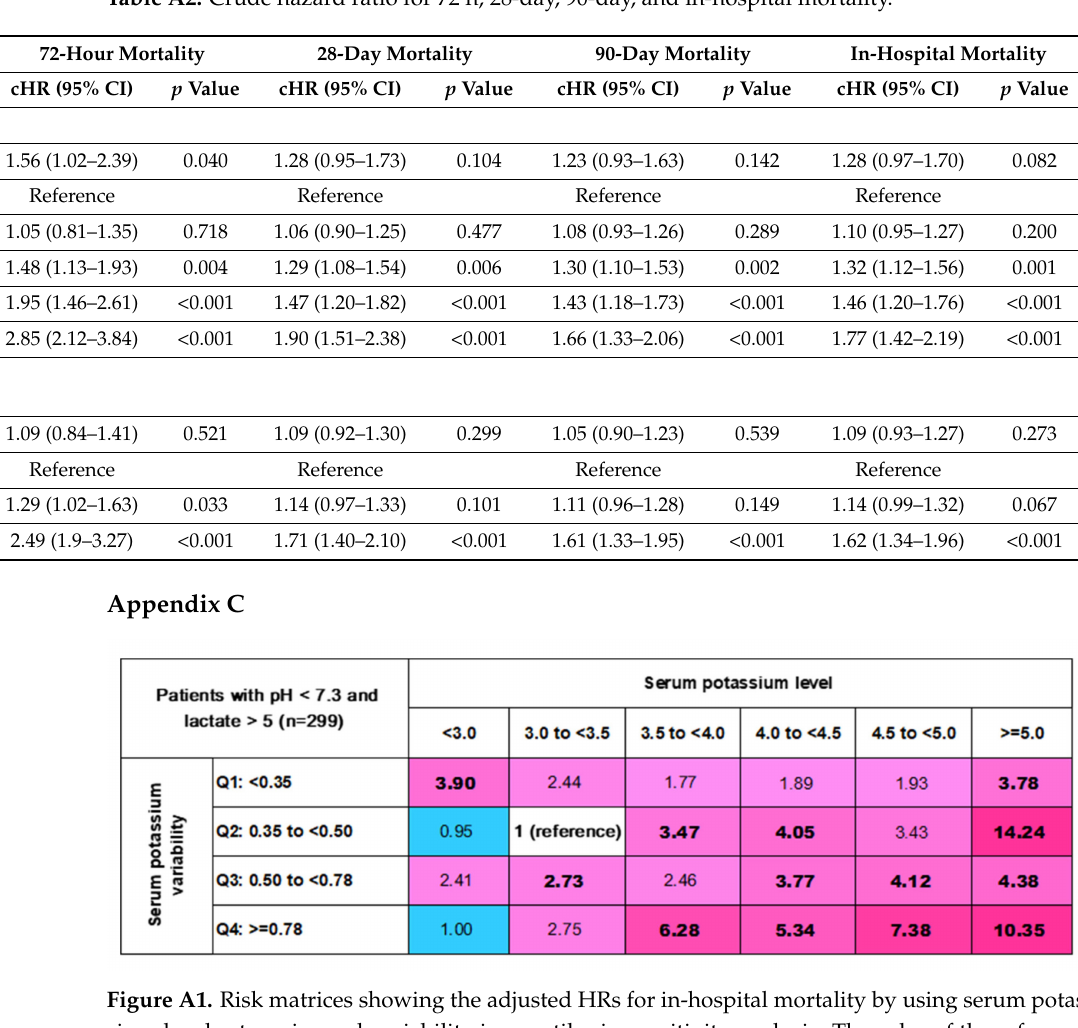
Figure A1. Risk matrices showing the adjusted HRs for in-hospital mortality by using serum potas- sium level categories and variability in quartiles in sensitivity analysis. The color of the reference cells is white. HR <1.0 were represented as blue, while HR >1.0 was pink. We color the cells from light to dark (away from 1.0). The numbers in bold indicate they are significant ( p <